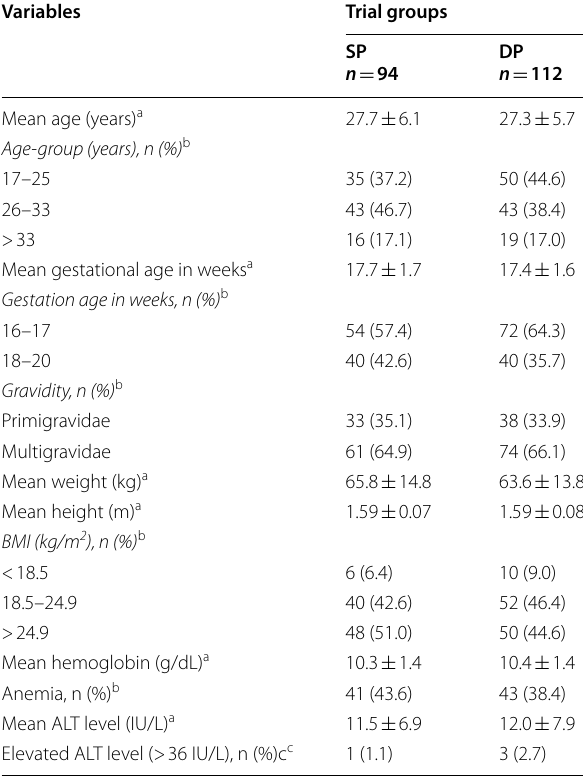
Table 1 Baseline characteristics of the participants that were followed up through delivery ( N =